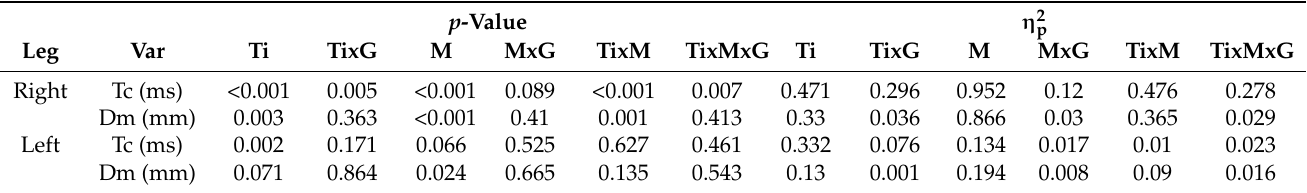
Table 5. Factors and interaction analysis in both legs.